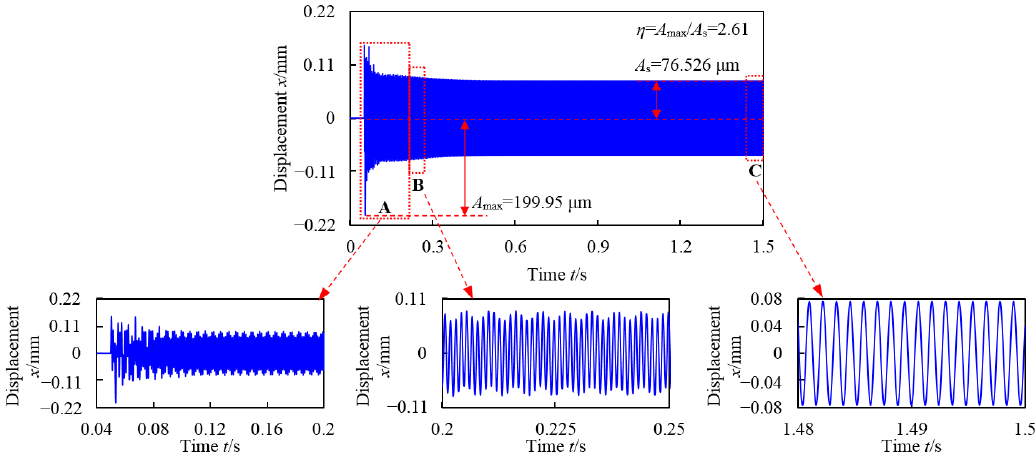
Figure 12. The time-domain response of 2# bearing in the horizontal direction.